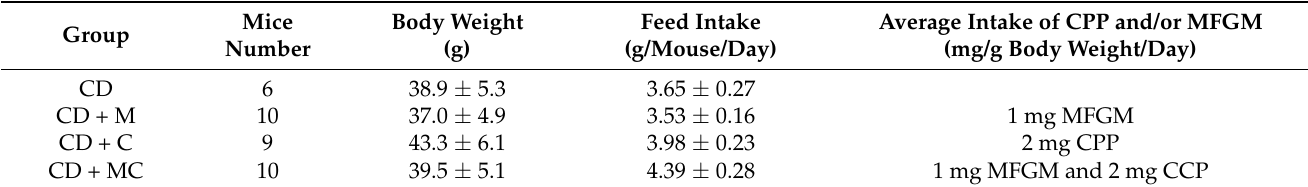
Figure 2. Reduction in mortality of SAMP8 due to CCP and MFGM intake. In the long-term experi- ments, SAMP8 mice ( n = 12/group) were fed diets containing CPP and/or MFGM ad libitum.